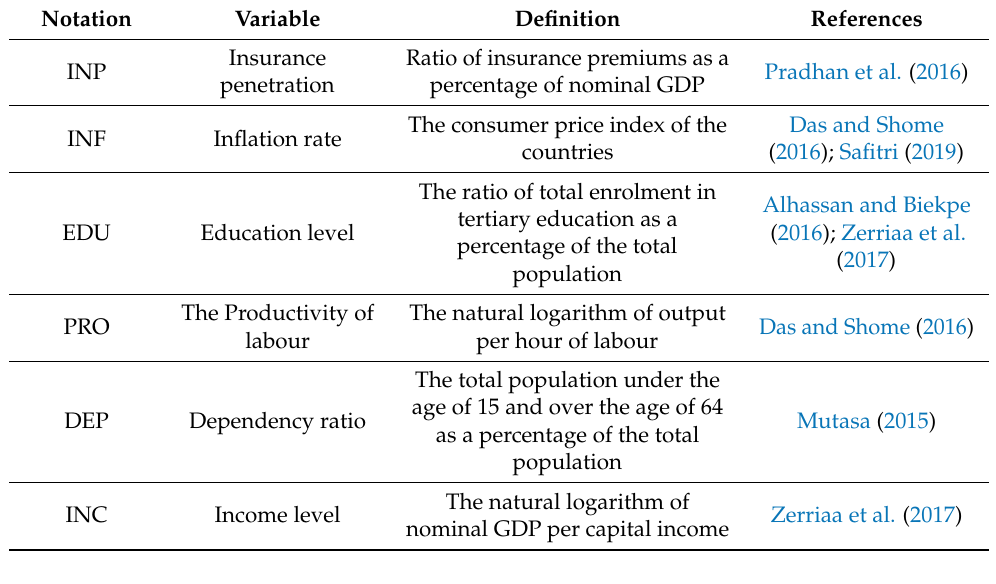
Table 1. Variable definition and